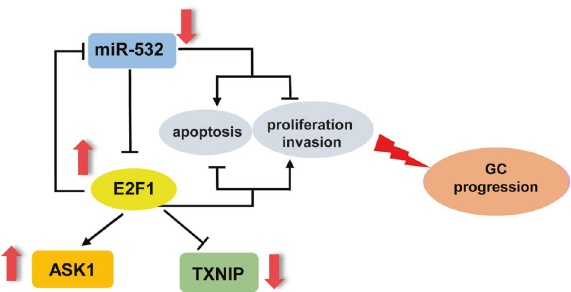
Fig. 8 Schematic for the E2F1-miR-532 loop in GC. The miR-532- E2F1 feedback loop contributes to gastric cancer